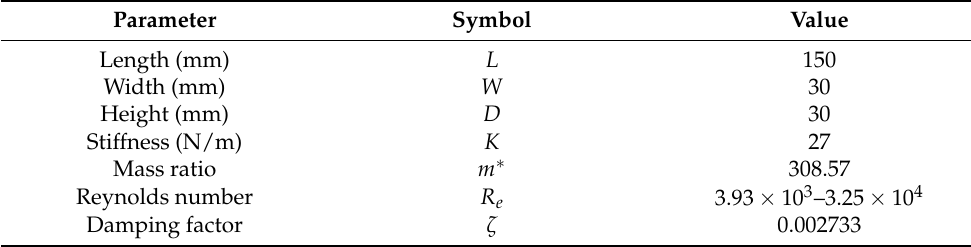
Table 1. SC-TENG parameters in smoke wire visualization